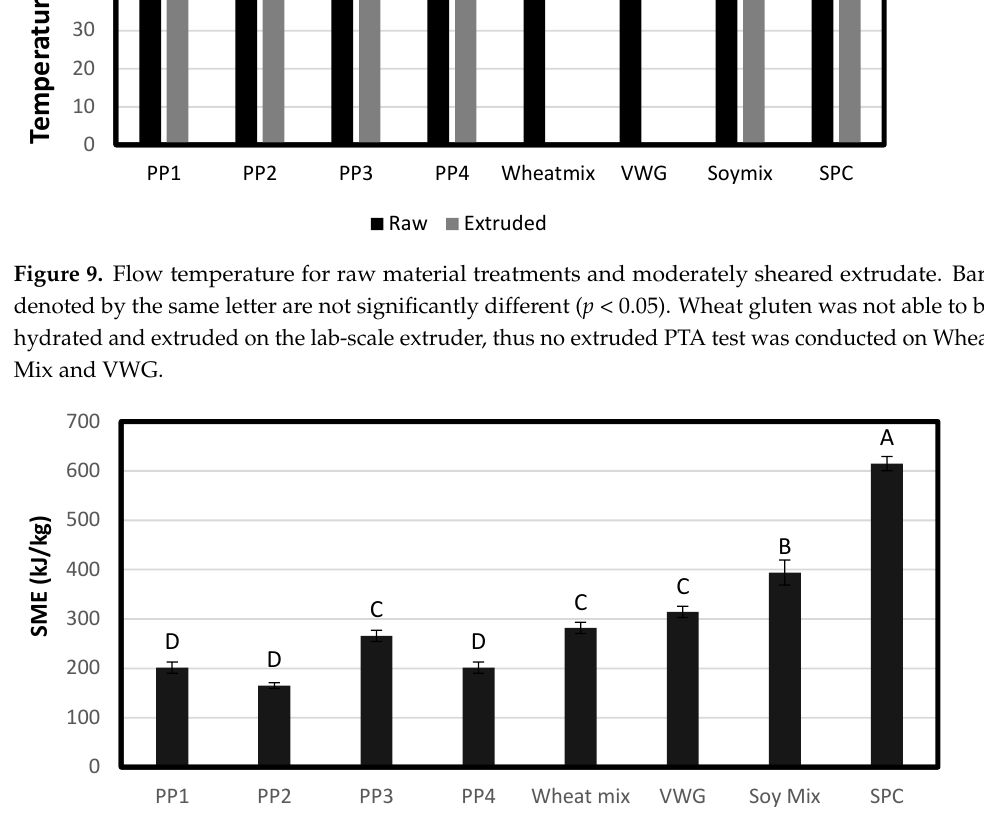
Figure 10. Mean SME required by each treatment during extrusion processing. Bars denoted by the same letter are not significantly different ( p < 0.05).